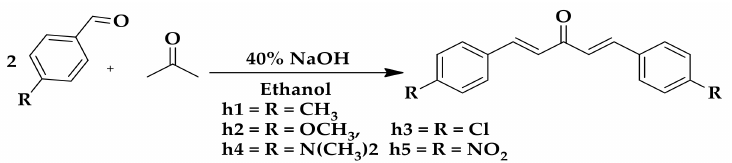
Figure 1. Mono-carbonyl curcumin analogs used in this study for memory enhancing